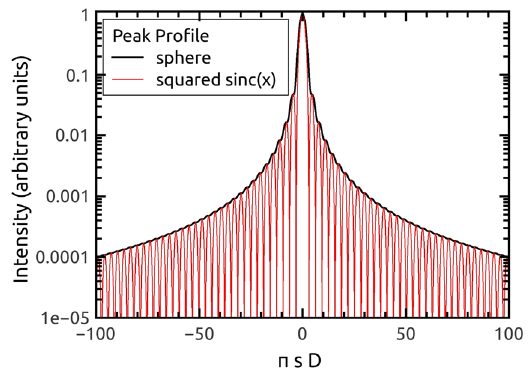
Figure 2. Theoretical peak profile due to spherical crystallites superposed with the squared sinc function